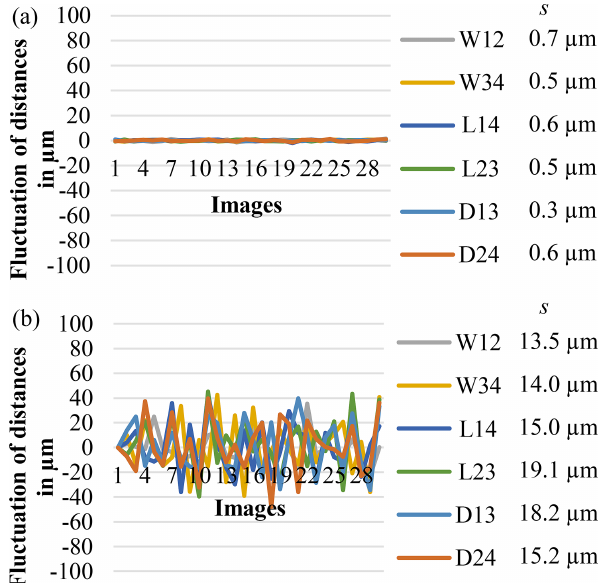
Figure 10. Fluctuation of determined distances of the reference pipes at (a) room temperature ( ∼ 23 ◦ C) and (b) process temper- ature ( ∼ 168 ◦ C).